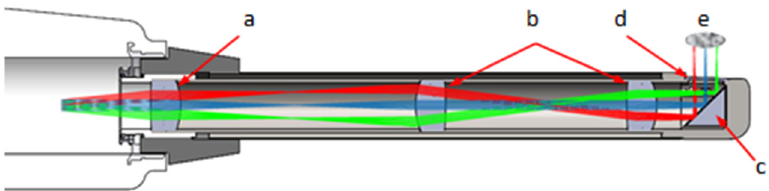
Figure 2. Simulated beamline of the intraoral probe with scan lens ( a ), relay-optics ( b ), silver-coated right-angle prism mirror ( c ), glass plate ( d ), and focal area ( e ).